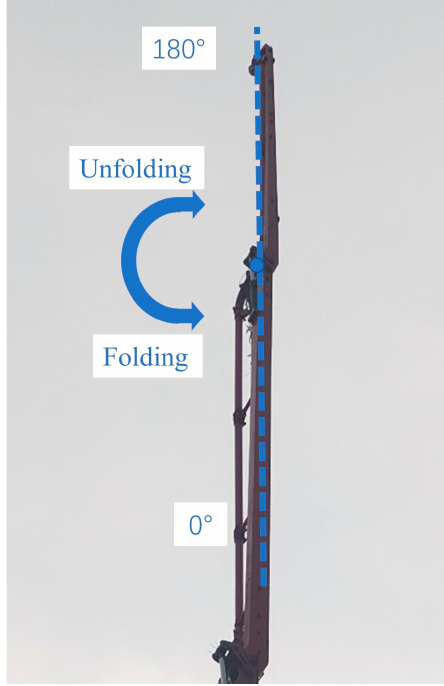
Figure 29. Movement schematic of boom section 6.